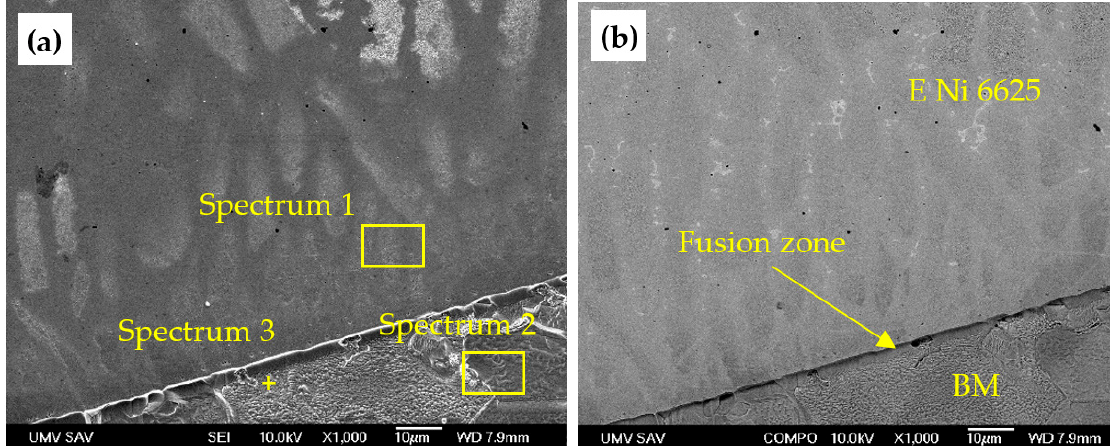
Figure 6. E Ni 6625/BM, semi-quantitative EXD microanalysis of the fusion zone ( a ), and the fusion zone, SEM-BSE ( b ). Table 3. EDX analysis of spectra 1–3, wt.%.